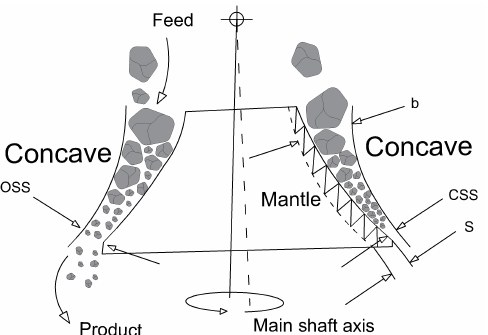
Figure 1. Schematic representation of a cone crusher, extracted from Yamashita et al.